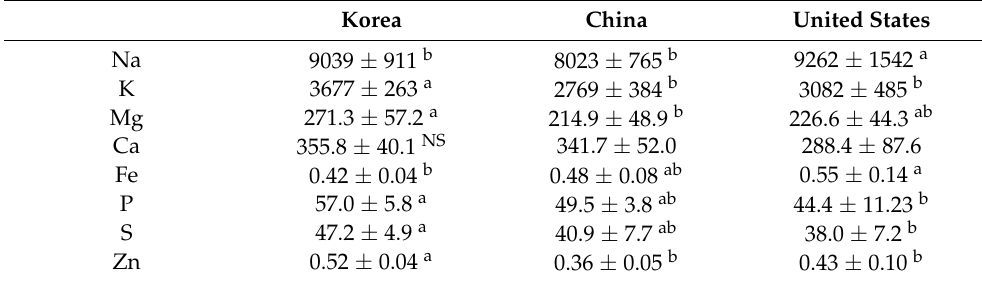
Table 2. Mineral contents of commercial kimchi manufactured in Korea, China, and the United States.